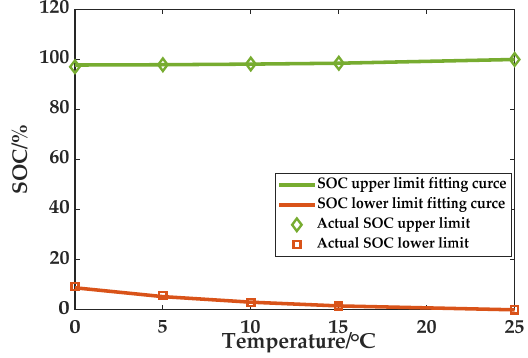
Figure 10. Fitting curves.